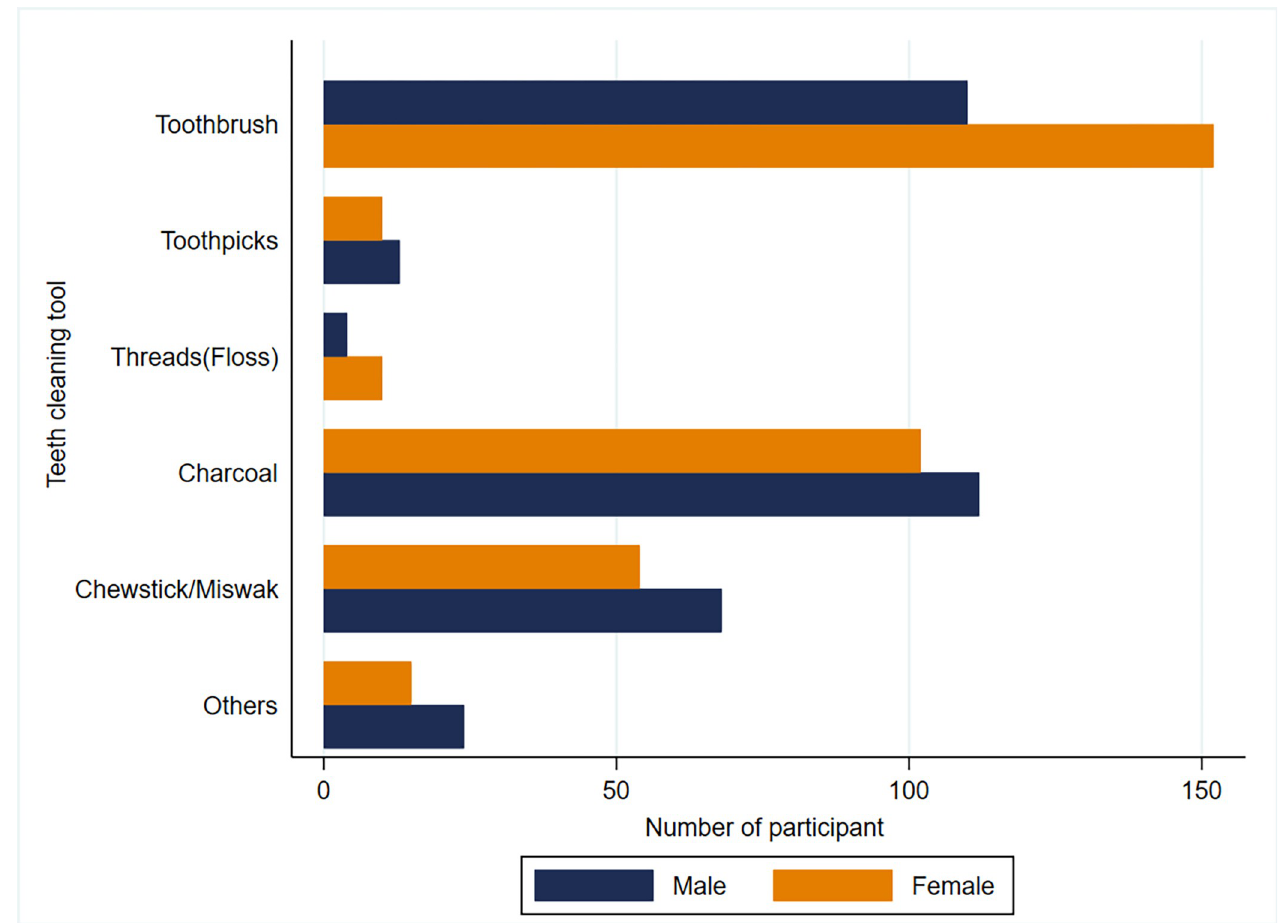
Fig 1. Bar chart showing teeth cleaning tool by gender of the